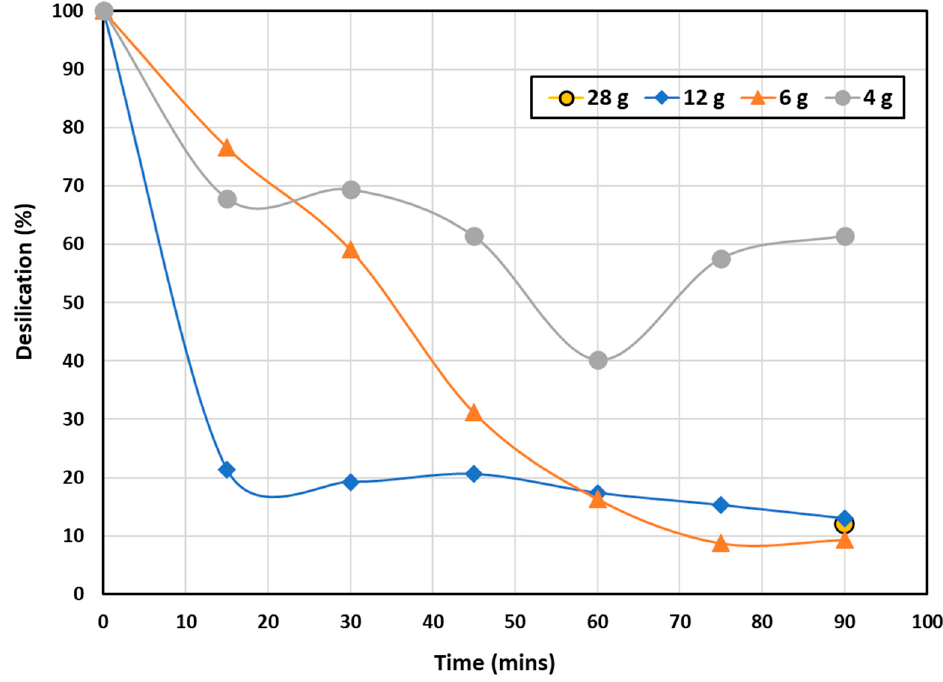
Figure 3. Percentage reduction of Si with time using 28 g [12], and tests 1, 2, and 7 with 12, 6, and 4 g of CaO at 90 °C for 90 min.